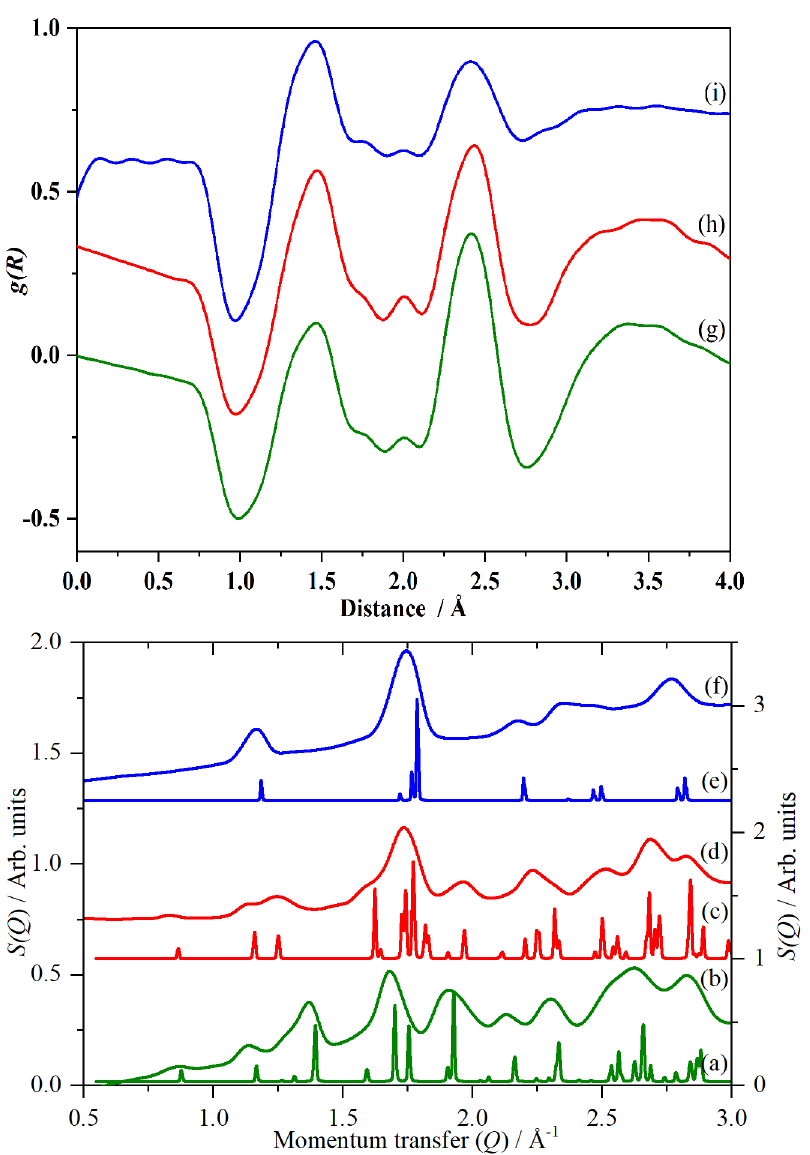
Figure 6. ( a – e ): Diffraction patterns of CsHSO 4 in: phase III at 290 K ( a ) calculated [6] and ( b ) this